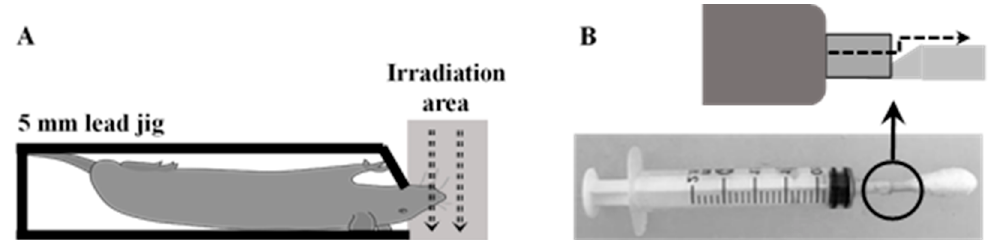
Figure 9. Radiation shielding materials box, oral administration device detail: ( A ) 5 mm lead jig allows for cranium irradiation. The gray dotted area indicates the irradiated area. ( B ) In-house built oral device with the detail shown above. A 2.5 mL syringe was repurposed. A groove was created to allow the solution to flow from the syringe into the cotton swab. The dotted line indicates the flow direction.